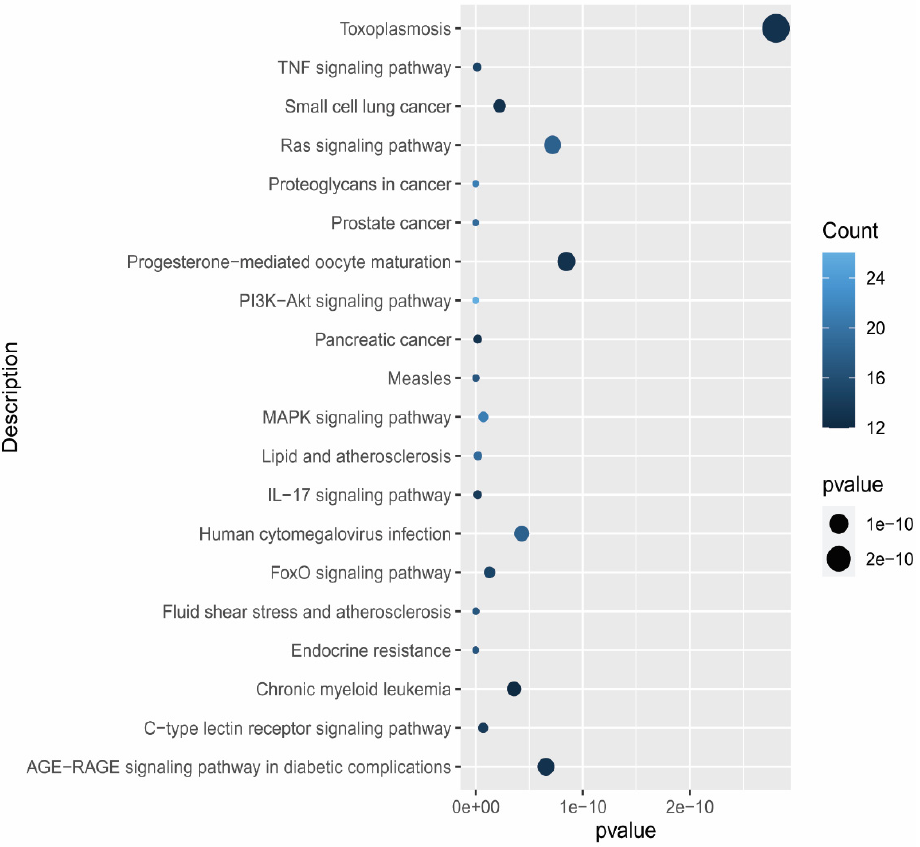
Figure 7. KEGG pathway enrichment analysis: 20 enriched pathways plotted through R